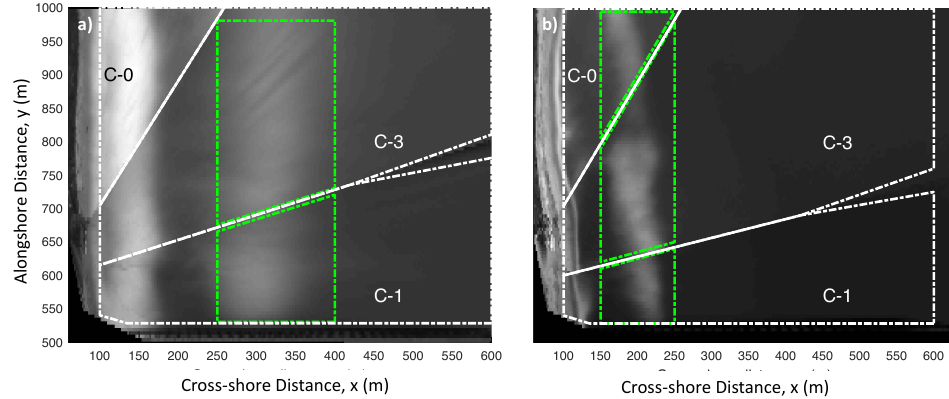
Figure 3. FRF facilities location and coordinate system. FOV denotes the field of view of the cameras, and the solid line is the swath of the marine radar. White dashed lines denote camera boundaries. Black and white image shows the pixel array used.